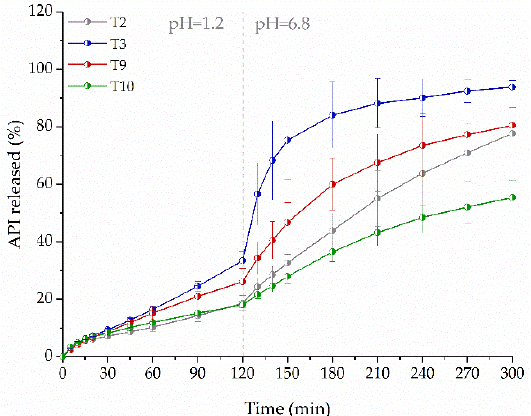
Figure 9. The influence of the disintegrants on dissolution profiles of ketoprofen from 3DP tablets (infill density equal to 35%, 40% of drug loading, dosage 75 mg).